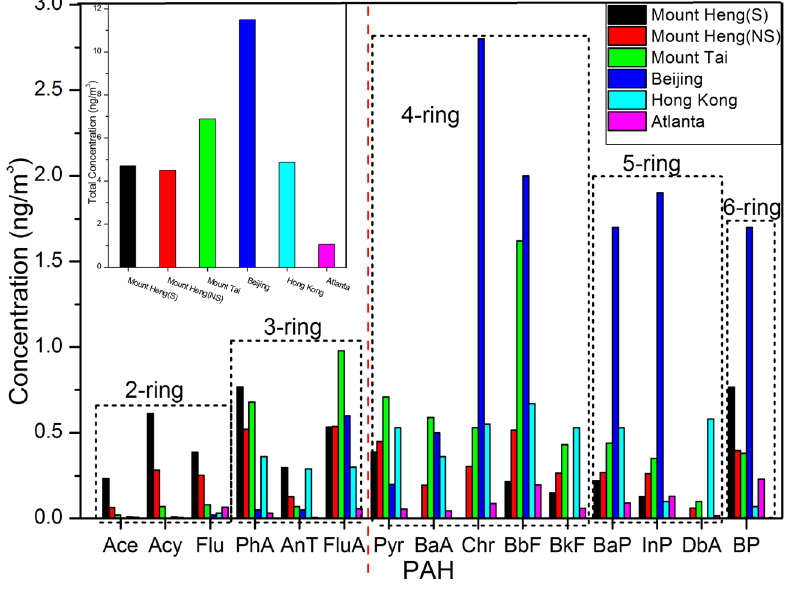
Figure 3. Average concentrations of PAHs in PM 2.5 at Mount Heng and other sites (S: sandstorm, NS: no